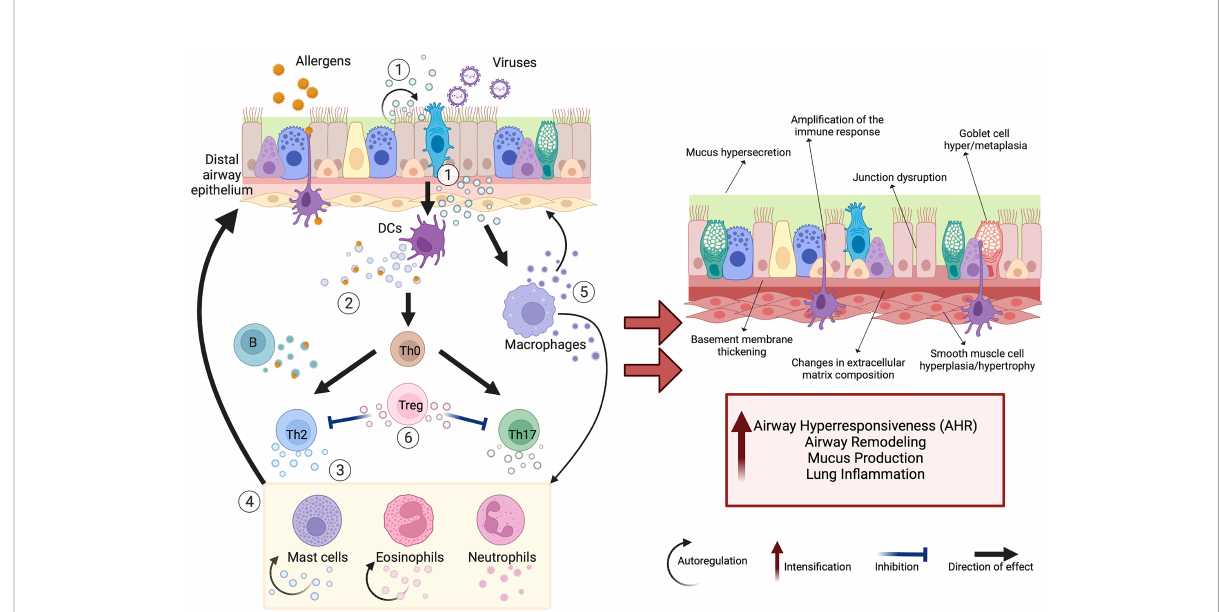
FIGURE 1 Schematic view of extracellular vesicles (EVs) as mediators of cellular interactions in the lung microenvironment. The complex EV-mediated crosstalk in the lung microenvironment occurs between many different cell types, including airway epithelial cells (AECs) and immune cells. Secreted EVs transfer speci fi c cargo (e.g., proteins, miRNAs, mitochondria), which modulates the activity of target cells and can support tissue homeostasis or promote chronic respiratory changes. The exposure of airway epithelium to various environmental triggers (e.g., viruses, allergens) stimulates increased release of EVs with changed cargo composition that plays a critical role in asthma pathomechanism (including airway remodeling, airway hyperresponsiveness (AHR), mucus hypersecretion, increased lung in fl ammation). These EVs act in several ways (1): AEC-derived EVs target dendritic cells (DCs), macrophages, and themselves, promoting Th2- and Th17-polarized immune activation (2). DC- derived and B-cell-derived EVs can induce T-cell responses and serve as “ antigen-presenting units ” (3). T-cell-derived EVs cause Th2 skewing, eosinophil, neutrophil, and mast cell activation (4); that cells in turn produce EVs driving airway remodeling, and supply nitric oxide and reactive oxygen species, increasing the migration of other eosinophils and mast cells to the in fl ammation site (5). Macrophage-derived EVs also participate in airway remodeling, synthesizing leukotrienes and recruiting granulocytes to the in fl ammation site (6). In contrast, regulatory T cell (Treg)-derived EVs initiate anti-in fl ammatory activities. Created with